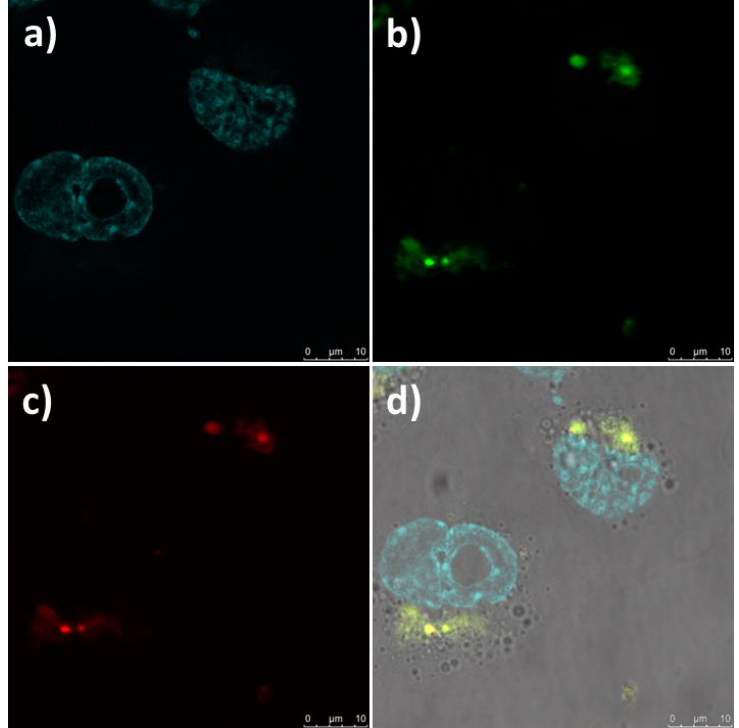
imaging of MDA-MB-231 cells by multi-photon excitation (980 nm laser excitation). The developed UCNC@SiO 2 has bright, dual color emission in both green and red channels. The UCNC@SiO 2 imaging further demonstrated that particles are localized in the cytoplasmic space after uptake. ( a ) Cell nuclei were visualized by 4′,6-diamidino-2-phenylindole (DAPI) staining, ( b ) The UCNC@SiO 2 can be seen as localized spots inside cells. The green emission form UCNC@SiO 2 was detected in 520–570 nm range. ( c ) The red emission from UCNC@SiO 2 can be seen again as localized spots in cells. The red